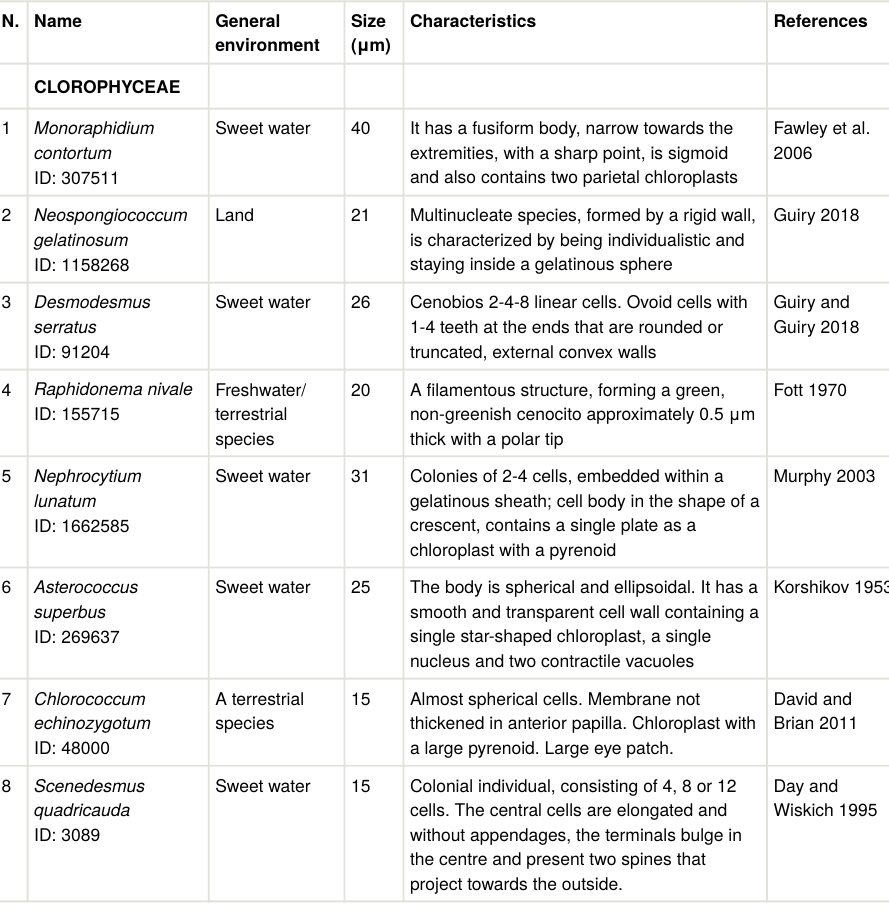
Analysis of the morphotypes identi fi ed in the hydrographic zones of the state of Chiapas according to the environment of isolation, class, size and morphological